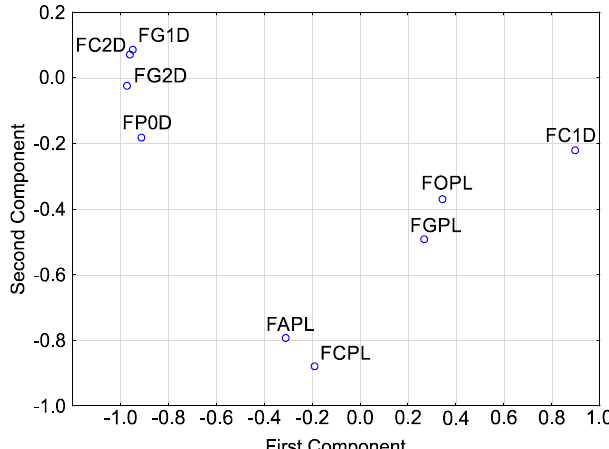
Figure 5. Variability of sensitivity of Fusarium spp. isolates—ordered after cluster analysis (D-Ger- many, PL-Poland.): FC2D— F. culmorum , FG2D— F. graminearum , FG1D— F. graminearum , FC1D— F. culmorum , FCPL— F. culmorum , FP0D— F. poae , FAPL— F. avenaceum , FOPL— F. oxysporum , FGPL— F. graminearum .